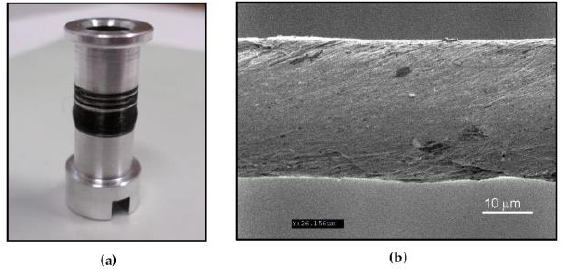
Figure 2. ( a ) Optical image of a spool with the CNT yarn; ( b ) Scanning Electron Microscope (SEM) image of a one-thread CNT yarn.